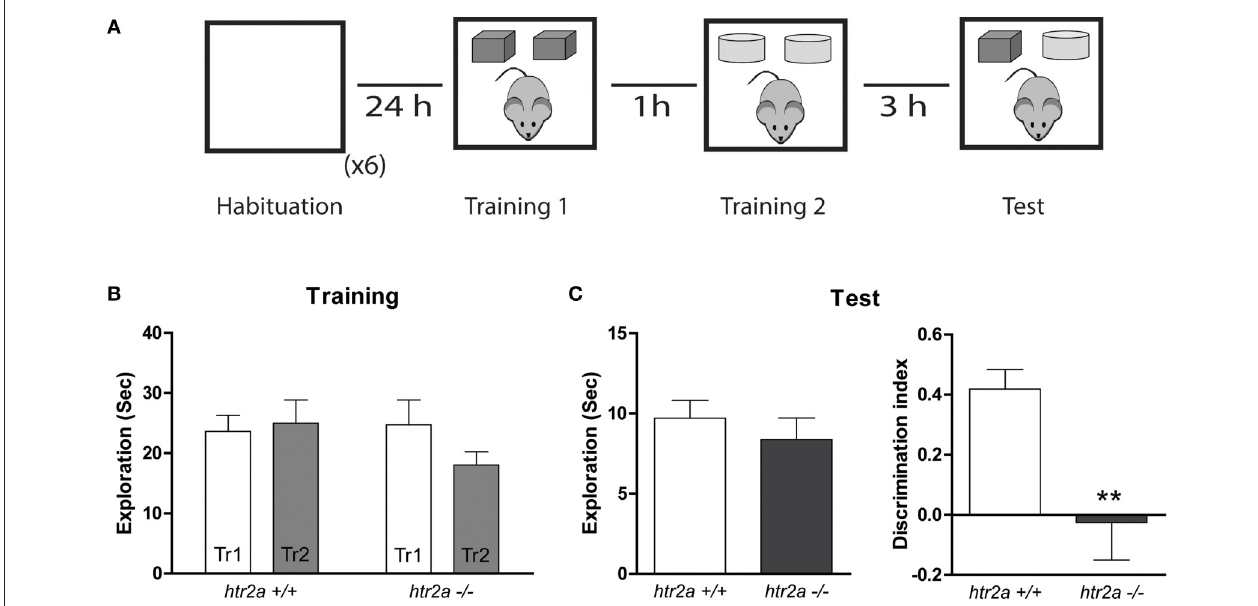
FIGURE 3 | 5-HT2aR is required for the temporal order recognition task. (A) Training and Testing scheme. The mice were exposed to an arena containing two identical copies of an object and an hour later they were re-exposed to the same arena containing two identical copies of a different object. Three hours later animals were exposed to the same context containing one copy of each object (“older” and “newer”). (B) Exploration time measured in seconds during the first and the second Training phases (Tr 1 and Tr2). (C) Total exploration measured in seconds (left) and Discrimination Index (right). DI was calculated as the time spent exploring the older object minus the time spent exploring the newer object over the total exploration time during the test session. n = 10 per group, ** p < 0.01 , Student’s t -test.